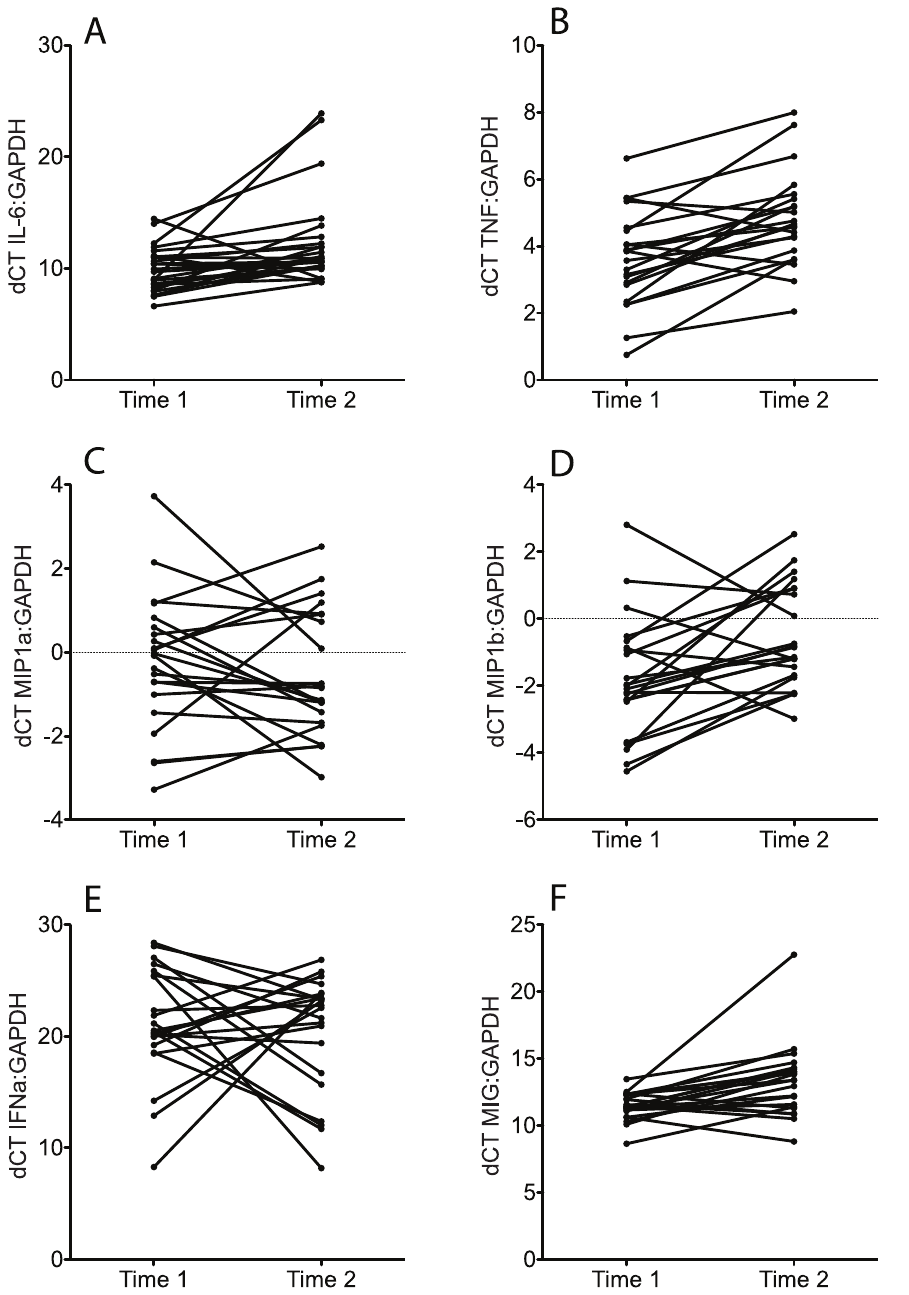
Figure 2. Comparison of relative concentration of for pro-inflammatory cytokine/chemokine mRNAs in vaginal secretions of RM in samples are similar. A) IL-6, B) TNF, C) MIP-1a, D) MIP-1b, E) IFNa, F) MIG. Time 1 indicates the CVS samples were collected in March 2011. Time 2 indicates that the CVS samples were collected in November 2011. All vaginal secretions were collected between menstrual cycle days 10–20.